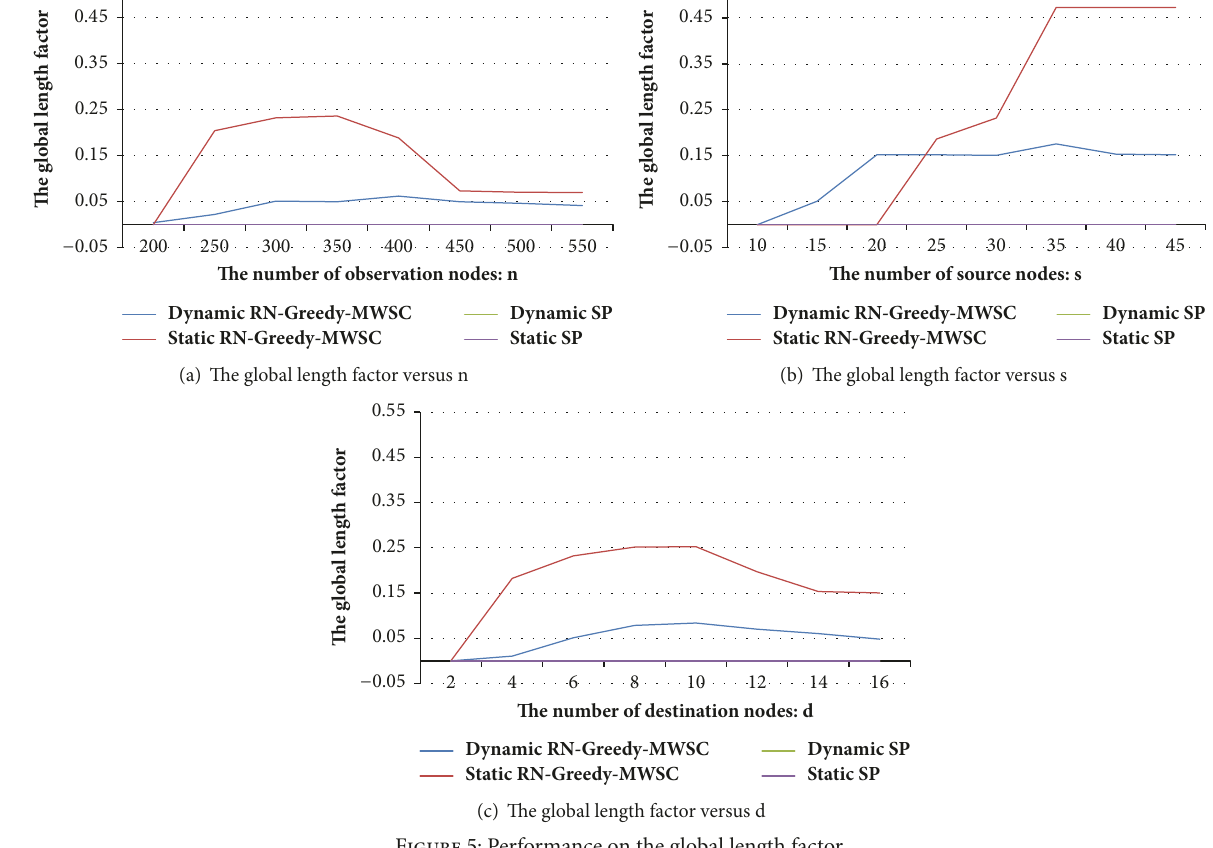
Figure 5: Performance on the global length factor. Table 2: Instance experiments